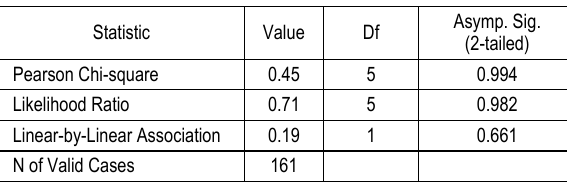
Table 8. Age versus risk perception